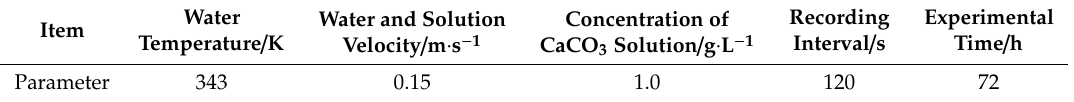
Table 4. Experimental parameters of flow